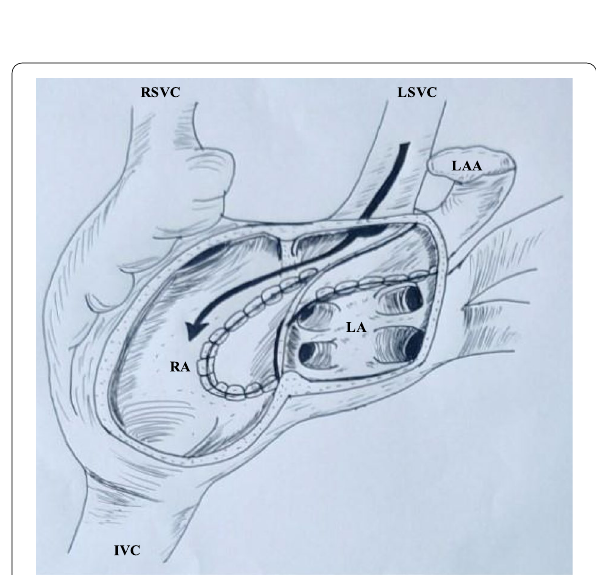
Fig. 4 Surgical diagram depicting atrial neo-septation with pericardial patch tailored such that the PLSVC drains to RA with LAA on right side of neo-septum. AV, atrioventricular; IVC, inferior vena cava; LA, left atrium; LAA, left atrial appendage; LSVC, left superior vena cava; LV, left ventricle; RA, right atrium; RSVC, right superior vena cava; RV, right